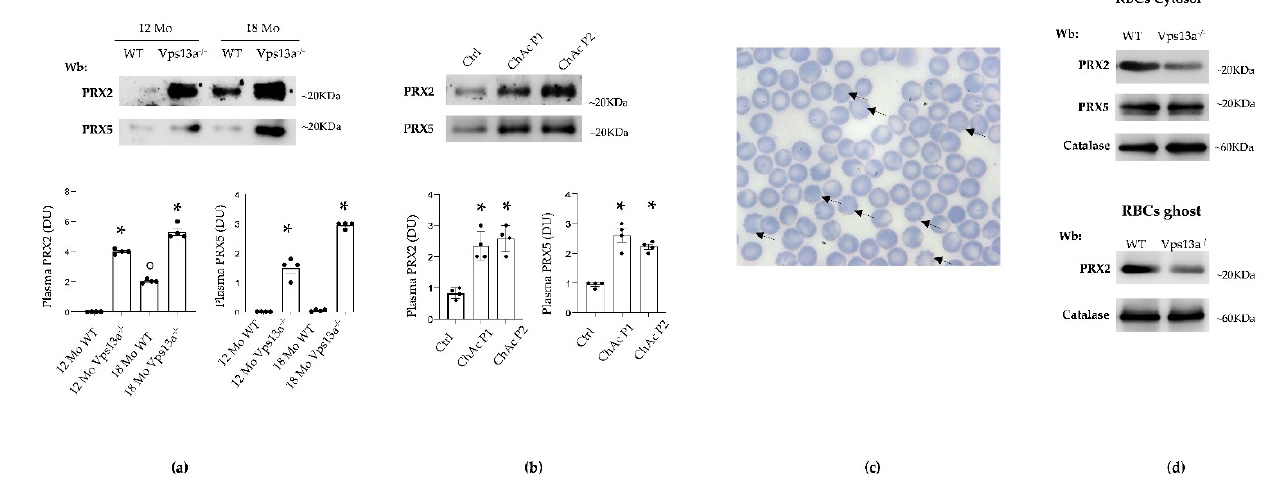
Figure 1. ( a ) Western blot analysis (Wb) of plasma from WT and Vps13a − / − mice at 12 and 18 months (Mo) of age, using specific antibodies against PRX2 and PRX5. One representative gel from 4 with similar results is shown. Densitometric analysis is shown in lower panel. Data are presented as means ± SEM, n = 4 * p < 0.05 compared to WT; ◦ p < 0.05 compared to 12 months old WT mice. Loading controls are shown in Figure S1a ( b ) Western-blot (Wb) analysis of PRX2 and PRX5 in plasma samples from healthy control (Ctrl), ChAc patient 1 (P1) and ChAc patient 2 (P2), corresponding to ChAc patients reported in De Franceschi L et al. [36]. Densitometric analysis is shown in lower panel. Data are presented as means ± SEM, n = 4 * p < 0.05 compared to healthy controls. Loading controls are shown in Figure S1b. ( c ) Morphologic analysis of peripheral blood from Vps13a − / − mice. Blood smears stained with May Grunwald Giemsa. Cells were imaged under oil at 100 × magnification using Panfluor objective 1.30 numeric aperture on a Nikon Eclipse DS-5 M camera and processed with Digital Slide (DS-L1) Nikon. Black arrows indicate acanthocytes in Vps13a − / − mice. ( d ) Western-blot (Wb) analysis of PRX2 and PRX5 in cytosolic fraction (upper panel) and of PRX2 in membrane fraction (ghost, lower panel) from red cells (RBC) of WT and Vps13a − / − mice at 12 months of age. Catalase was used as protein loading control. The blot shown is representative of four with similar results. Densitometric analyses are presented in Supplementary Figure